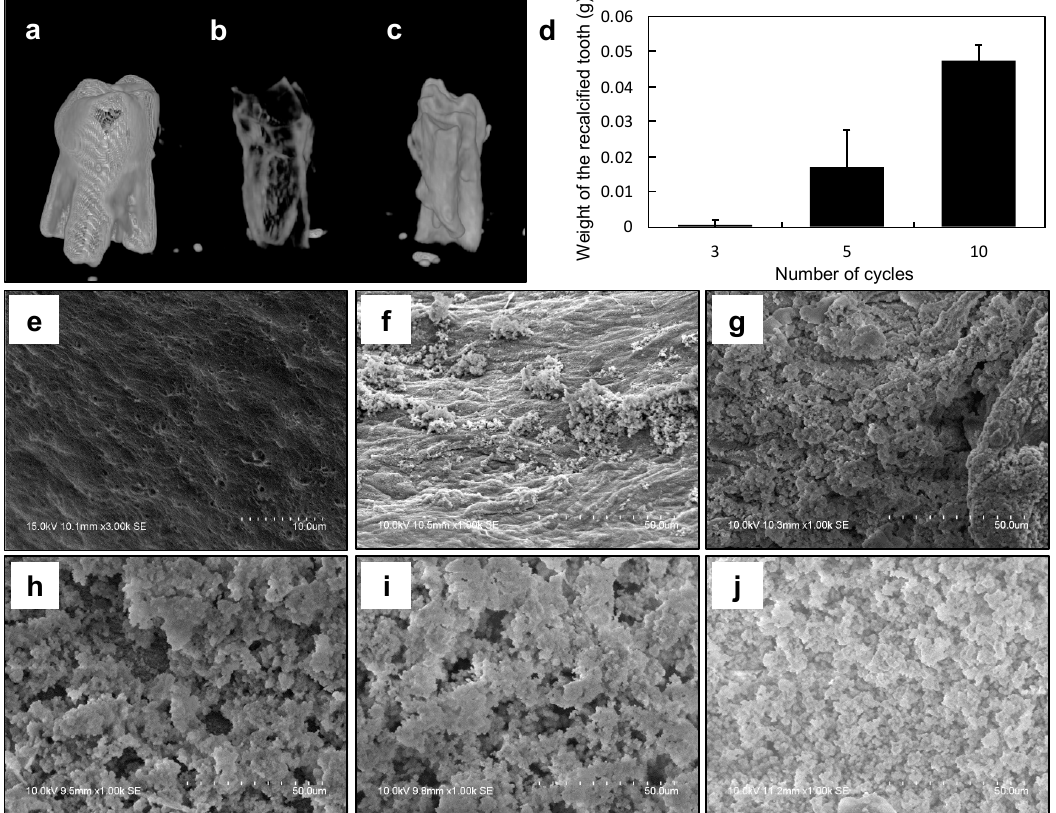
Figure 4. ( a – c ) Micro-computed tomography ( µ CT) images of extracted decellularized tooth ( a ), decalcified tooth ( b ), and re-calcified tooth ( c ). ( d ) Measurement of weight after alternate soaking. ( e – j ) Scanning electron microscopy (SEM) images of modified tooth surface of the decalcified sample ( e ) and after three ( f ), four ( g ), six ( h ), eight ( i ), and 10 ( j ) cycles.